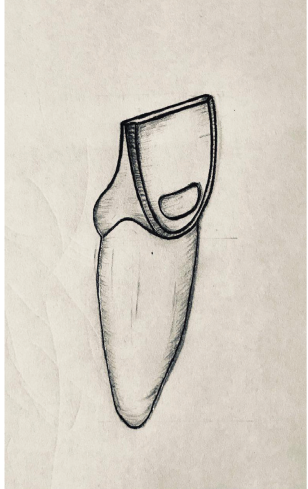
Figure 3: Schematic representation of final